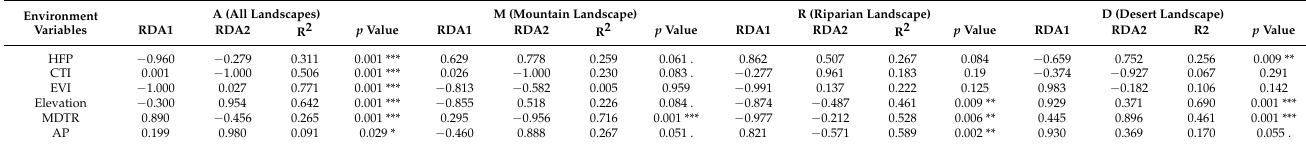
Table A2. The effect of each environment variable on bird species composition in mountain landscape, riparian landscape, desert landscape and across all landscapes based on Redundancy